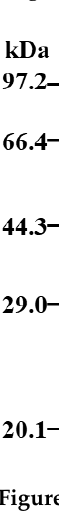
Figure 6. Storage stability of KsLX3 ‐ SIase. Data are the means ± SD from triplicate samples. The time ‐ course reaction catalyzed by KsLX3 ‐ SIase produced in B. subtilis was inves ‐ tigated by employing various sucrose concentrations. As depicted in Figure 7, the maxi ‐ mum yields of isomaltulose were 84.2 ± 0.3%, 84.2 ± 1.4%, and 87.8 ± 0.3% when the su ‐ crose concentrations used were 80 g/L, 120 g/L, and 160 g/L, respectively, demonstrating that a high yield of isomaltulose could be obtained with this enzyme in the presence of a high sucrose concentration. In addition, the rate of isomaltulose yield was rapid during the initial 60 min but then decreased with further culturing time, for all three concentra ‐ tions of sucrose. This phenomenon might be explained by the inhibitory effect of the by ‐ products, glucose and fructose, or the reduced stability of SIase in the high viscosity of the reaction mixture. A high yield of isomaltulose is necessary for its cost ‐ effective industrial production. The yield we obtained for KsLX3 ‐ SIase was greater than that reported for the SIase from Enterobacter sp. The yields of isomaltulose achieved with FMB ‐ 1 expressed in